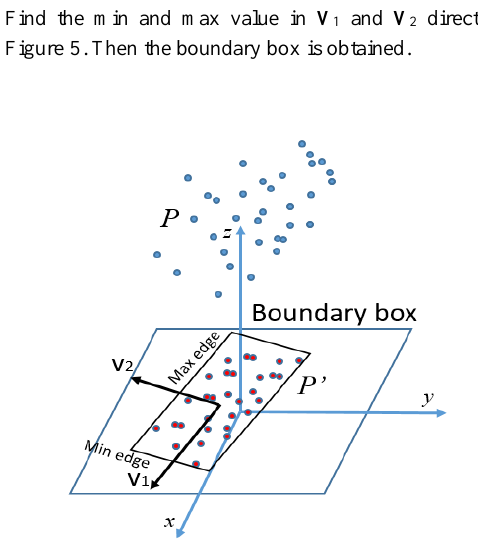
Figure 5 the boundary box in ground